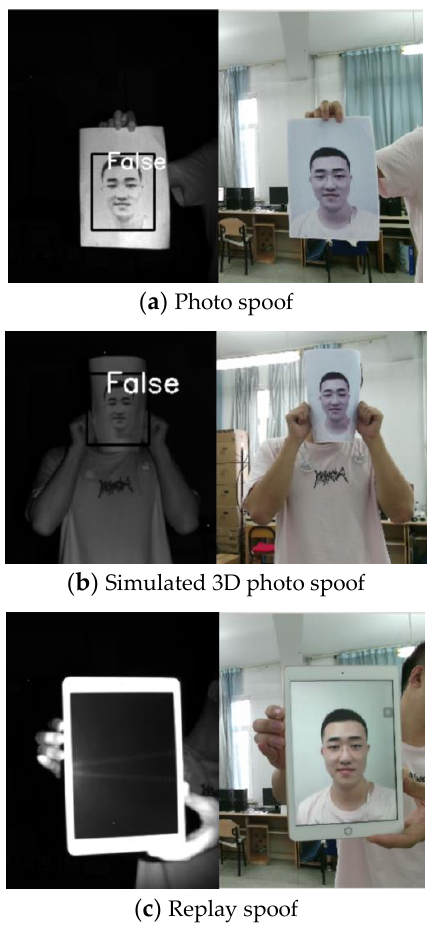
Figure 8. Spoof pictures.